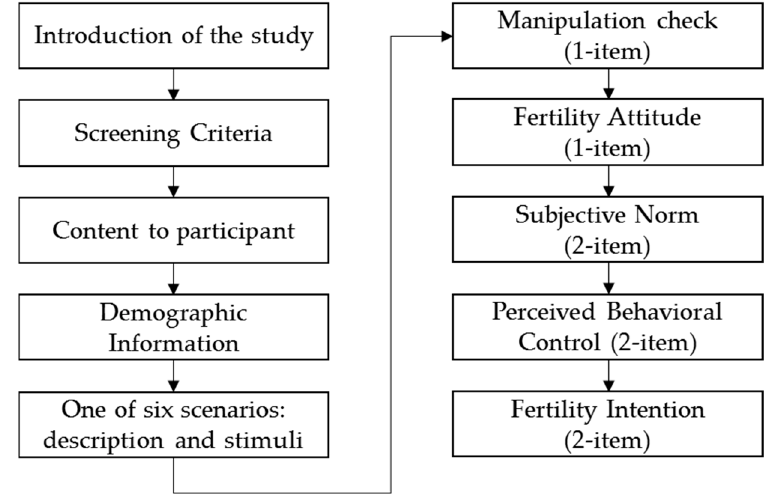
Figure 3. The experimental procedure in this study.